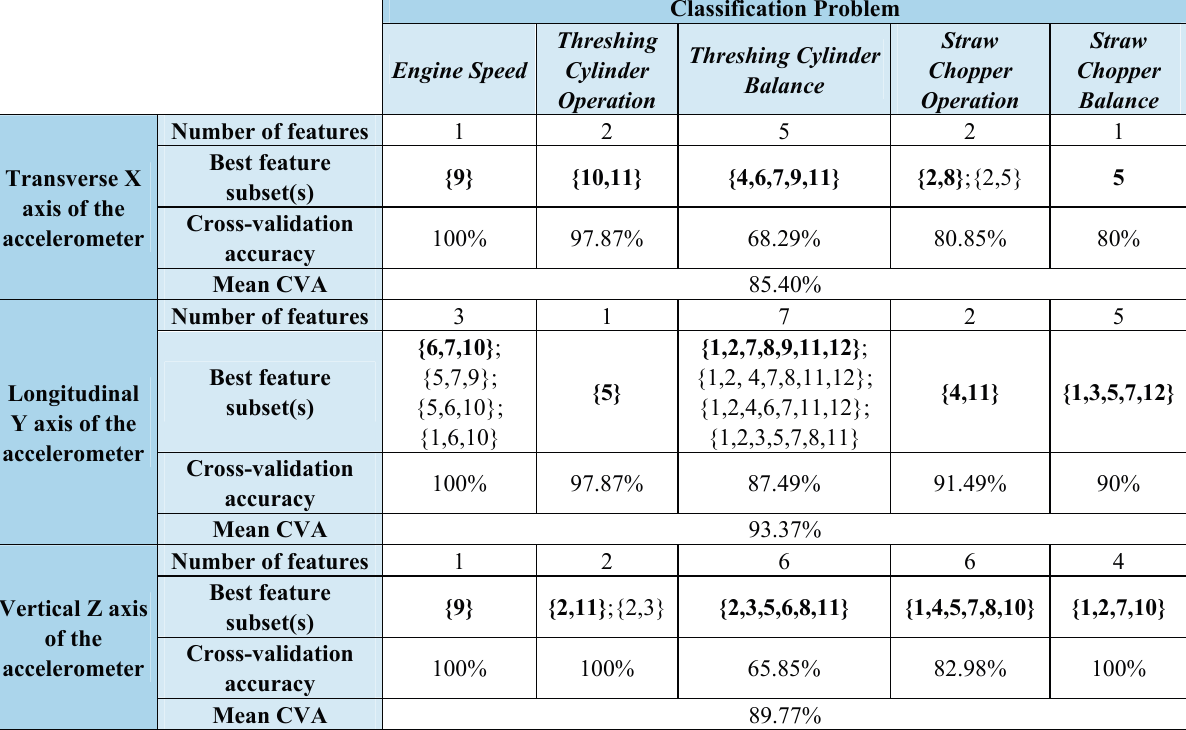
Table 1. Feature selection results for each of the three axes acquired by the triaxial accelerometer. The first row (number of features) shows the optimal number required to achieve the best cross-validation accuracy. The second row (best feature subset) shows all of the concrete feature subsets, giving the highest cross-validation accuracy as a list of numbers the legend of which corresponds to the list provided in Section 3.3. The subset employed for the subsequent classifier performance evaluation stage appears in bold. Each column corresponds to each of the rotating component classification problem under consideration.